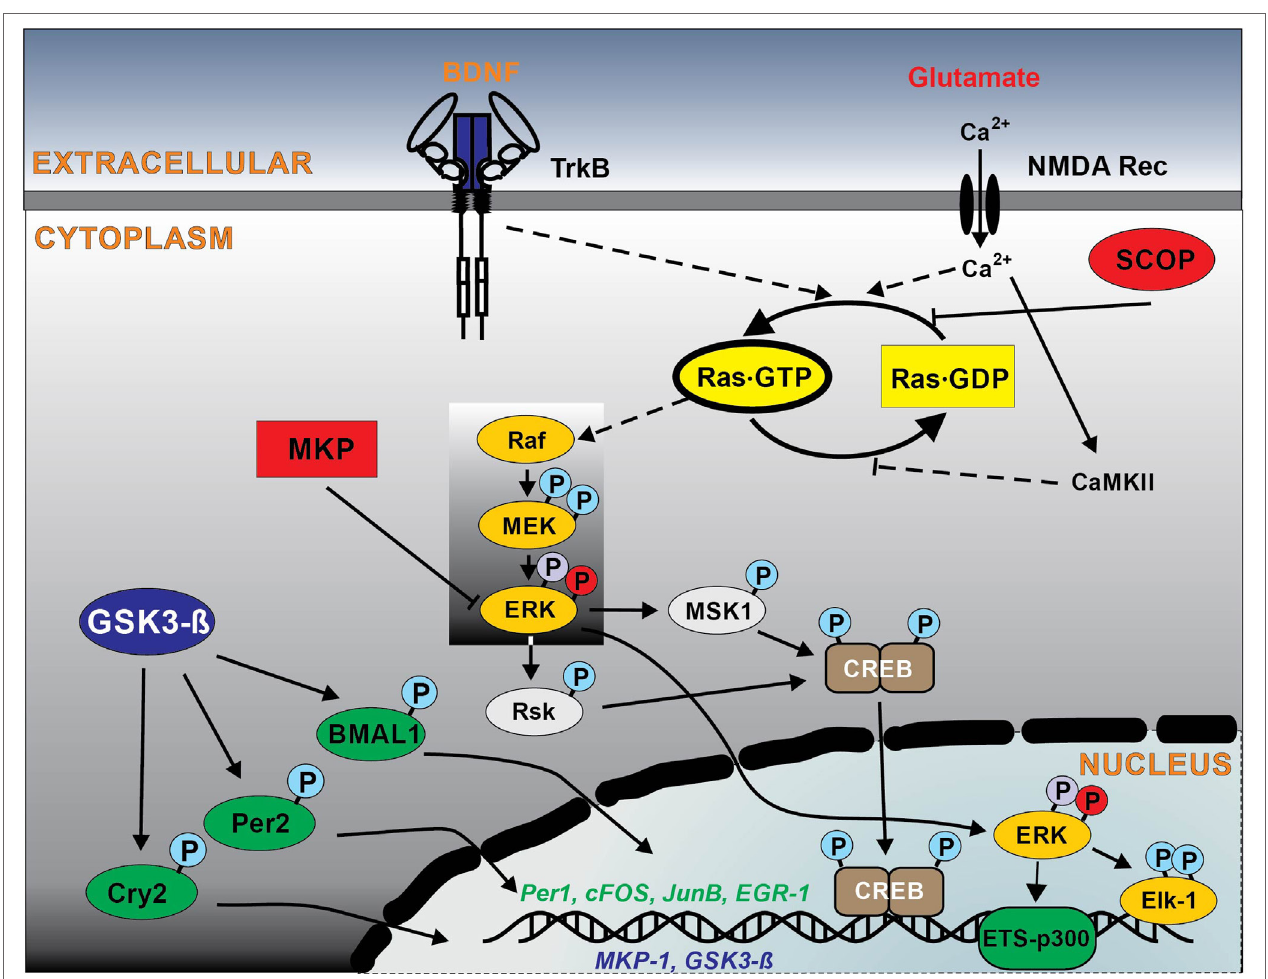
FiGURe 1 | Schematic outline of intracellular Ras signaling pathways in the suprachiasmatic nucleus (SCN) regulating circadian clockwork. Solid lines show the signal pathways observed in the SCN, and broken lines indicate hypothetical pathways observed in other neuronal systems. Glutamate/NMDA and brain-derived neurotrophic factor (BDNF)/TrkB are the major ligand–receptor systems within SCN involved in the light-induced phase shifting circadian clock. The light stimuli at night induce glutamate and BDNF release, which result in activation of NMDA receptors (with a subsequent influx of Ca 2 + , activating the Ca 2 + -calmodulin kinase II) and TrkB receptor that in turn stimulates Ras. Ras is also negatively regulated by the circadian protein SCN circadian oscillatory protein (SCOP). Ras activates ERK1,2 pathway, which couples to transcriptional factors CREB and Elk-1 phosphorylation, that regulate the transcription of the immediate early genes sFos, JunB, and EGR1, clock protein Per1, the regulator of ERK1,2 pathway MAPK phosphatase 1 (MKP-1). Enhanced Ras signaling via ERK1,2 also activates ETS-p300 transcriptional complex, which in turn regulates circadian clock proteins modulator glycogen synthase kinase-3 beta (GSK-3 β ). Other abbreviations are explained